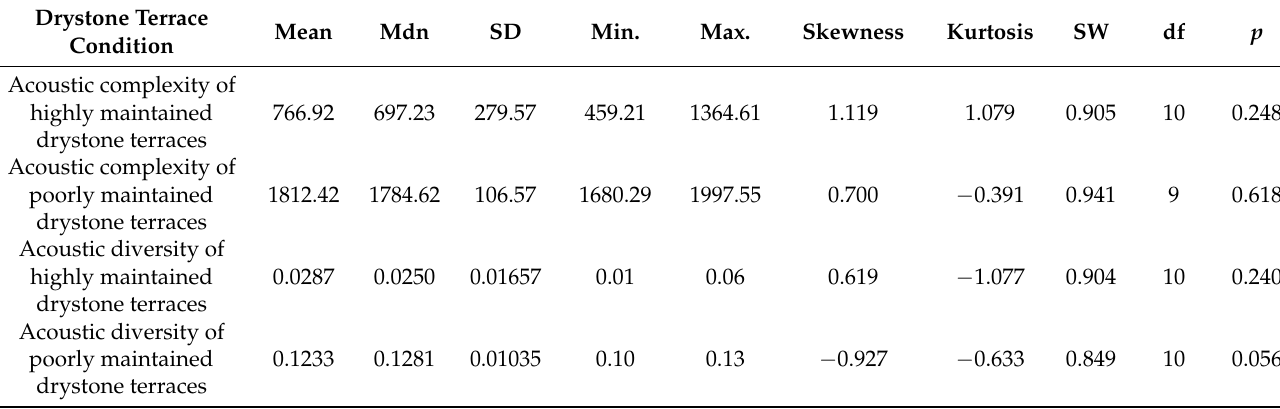
Table 1. Descriptive statistics and Shapiro-Wilk (SW) test of normality